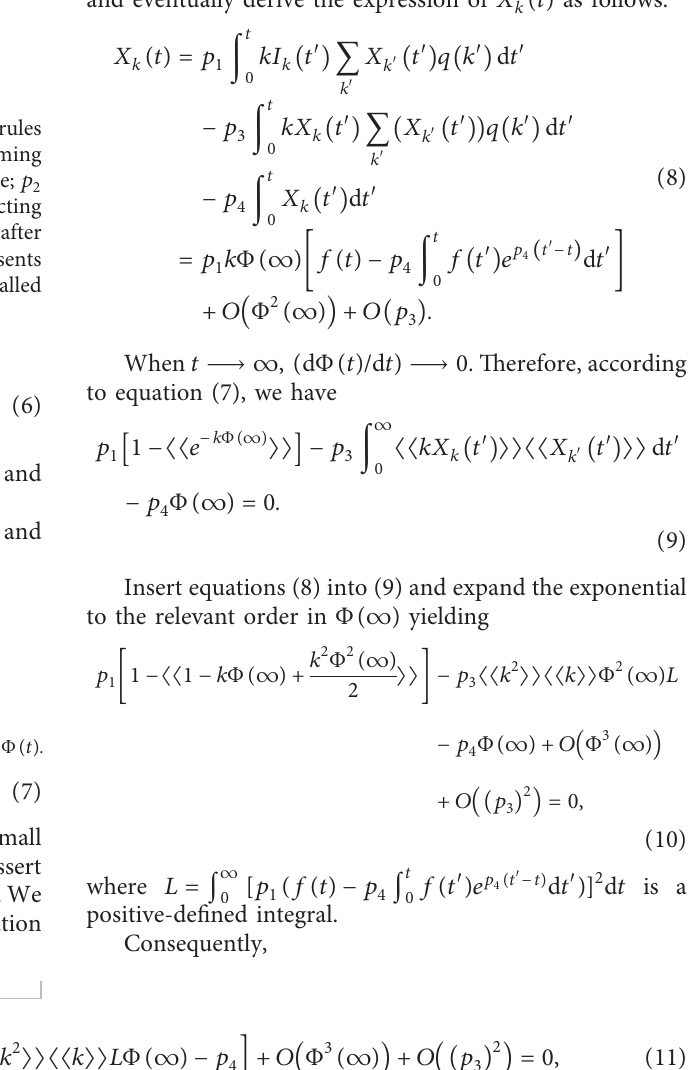
Figure 1: Transformation relationships and interaction rules among I , S , R , and C for scale-free networks where α represents probability of transforming from I to S after contacting (S) called rumor spreading rate; a represents probability of transforming from I to C after contacting ( S ); a contacting ( S ); a 2 S after contacting ( S ); b represents probability of transforming from I to R after contacting ( C ); b 1 from I to C after contacting ( C ); θ represents probability of transforming from S to R after contacting ( C ) called self-purification level; and β represents probability of transforming from S or C to ( R ) called forgetting rate.